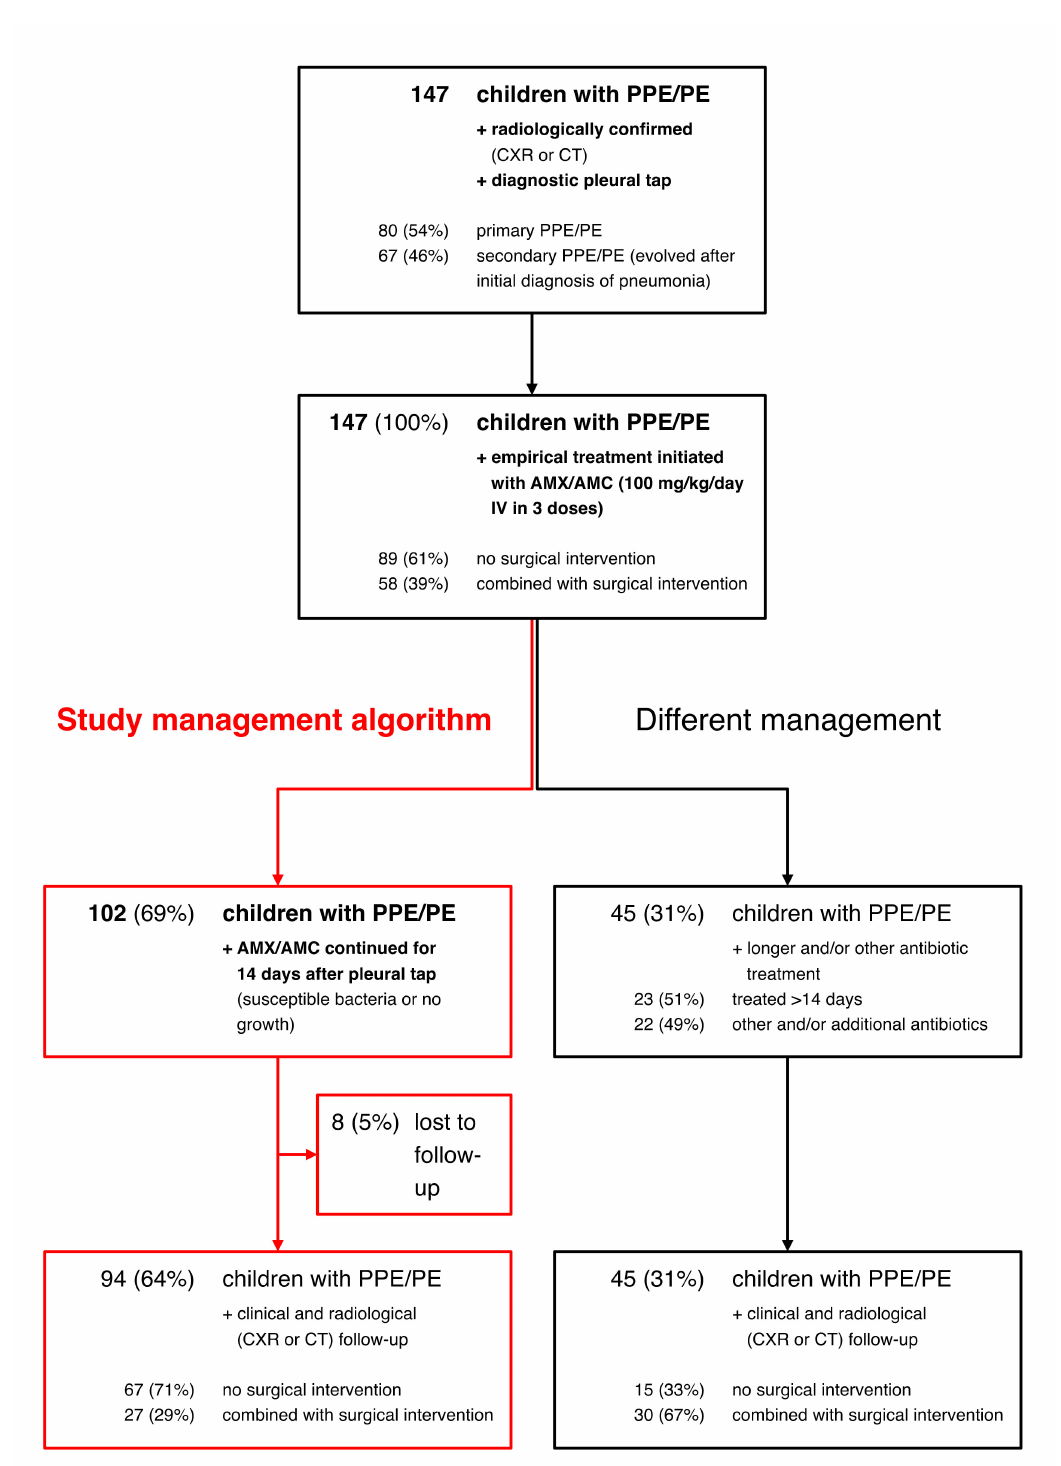
Figure 1. Study profile. AMC, amoxicillin-clavulanate; AMX, amoxicillin; PE, pleural empyema; PPE, parapneumonic e ff usion; CT, computed tomography; CXR, chest